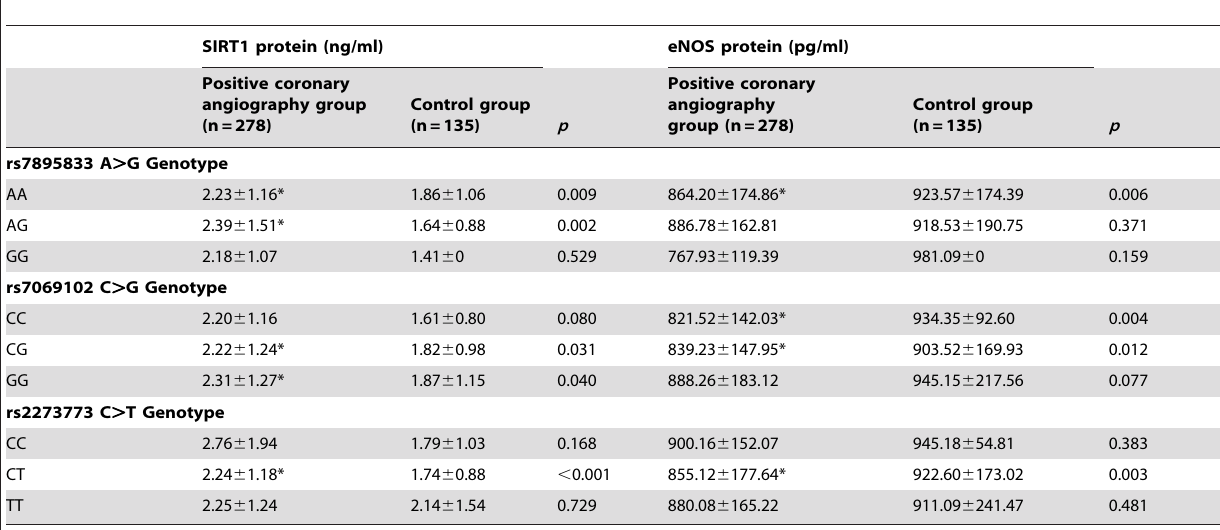
n: number of individuals. Statistical evaluation by the Student’s t-test. The results are shown as mean 6 Standart Deviation (SD). *p ,